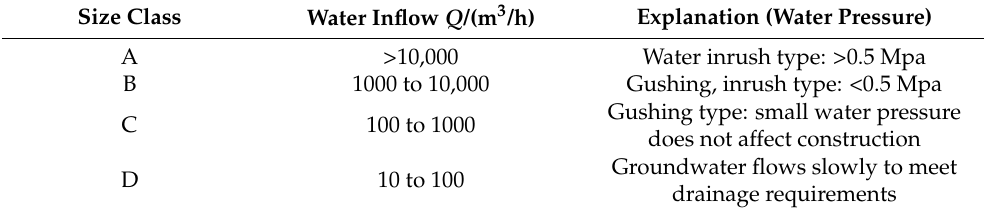
Table 3. Classification of water bursts based on water volume.